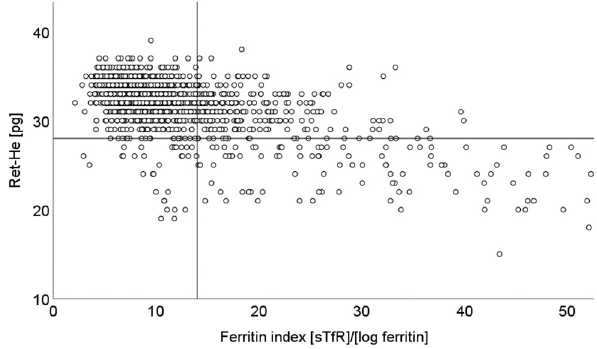
Figure 2: Thomas-plot of all 1459 cases. Cutoff value for the ferritin index: 14, cutoff value for RET-H e : 28 pg. Quadrant upper left: ACD, quadrant upper right: latent ID, quadrant lower right: IDA, quadrant lower left: FID/ACD.